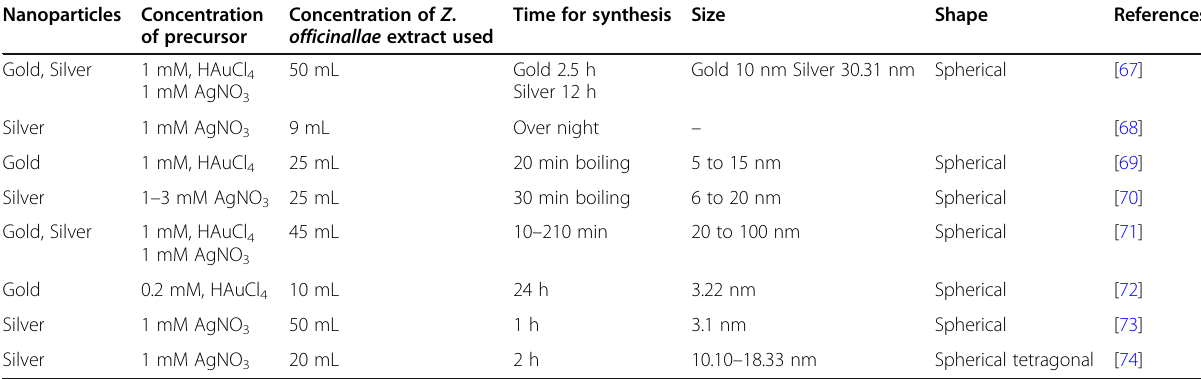
Table 2 Synthesis parameters and characters of nanoparticles synthesized using plant Z . officinallae Nanoparticles Concentration Concentration of Z . Time for synthesis of precursor officinallae extract used